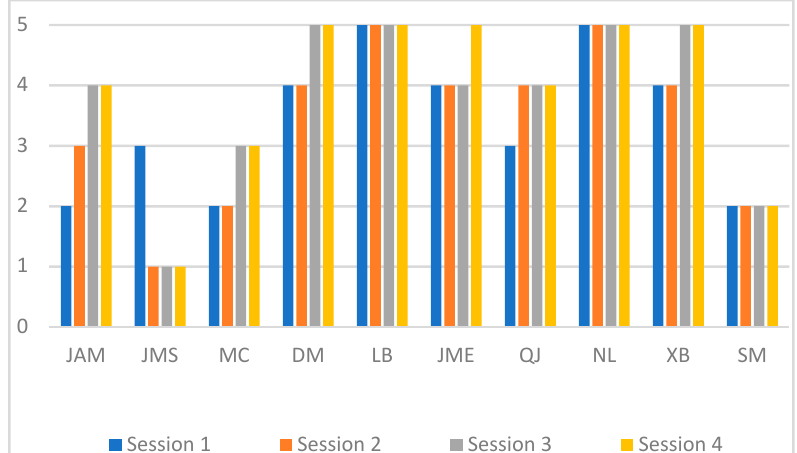
Figure 1. Indicators of degree of motivation (4–5: High; 3: Intermediate; 2–1: Low) for each session of each player.